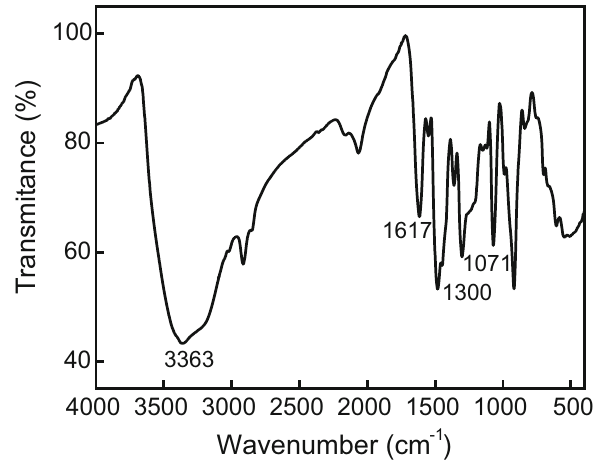
Fig. 1 FT-IR spectra of DTC chelating